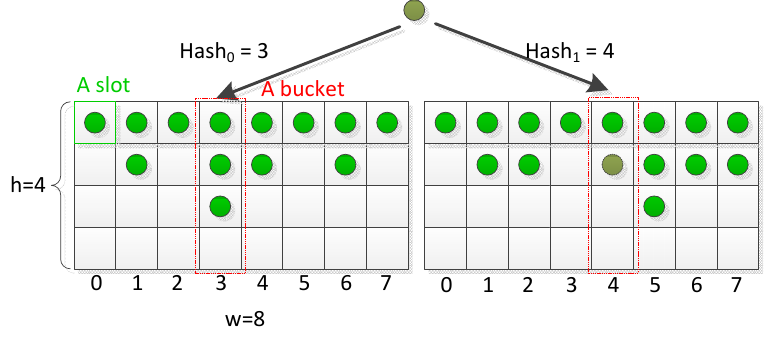
Figure 1. The procedure of D-left